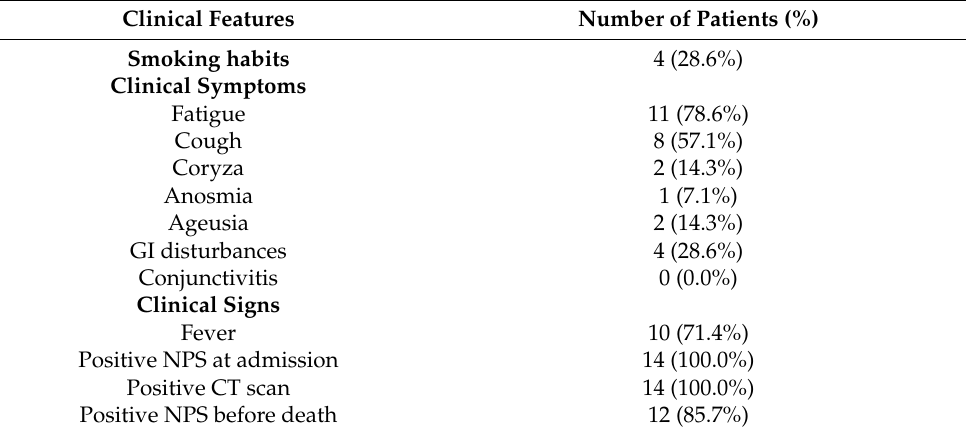
Table 1. Baseline clinical features of the selected cohort.